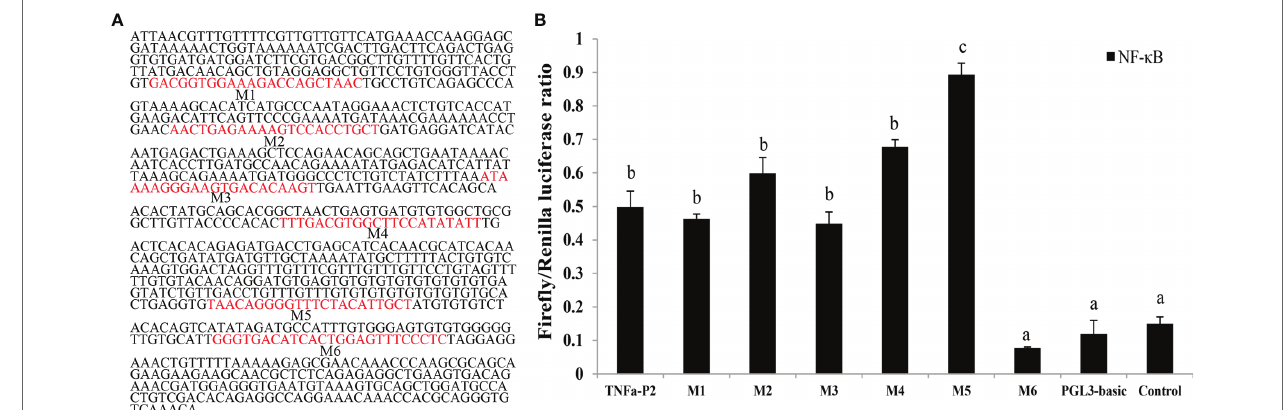
FIGURE 1 | Construction of truncated mutants for the identification of predicted transcription factor (TF) binding sites in the ToTNF α promoter. (A) The nucleotide sequence and predicted binding sites in the core region of the ToTNF α promoter. (B) Effects of three mutants on To TNF α -P2 promoter activity. Binding sites are shown with boxes. Mutations of promoter sequences are listed in Table 2 . Data are presented as the means of three replicates ± SE. Different letters indicate significant differences ( p < 0.05).